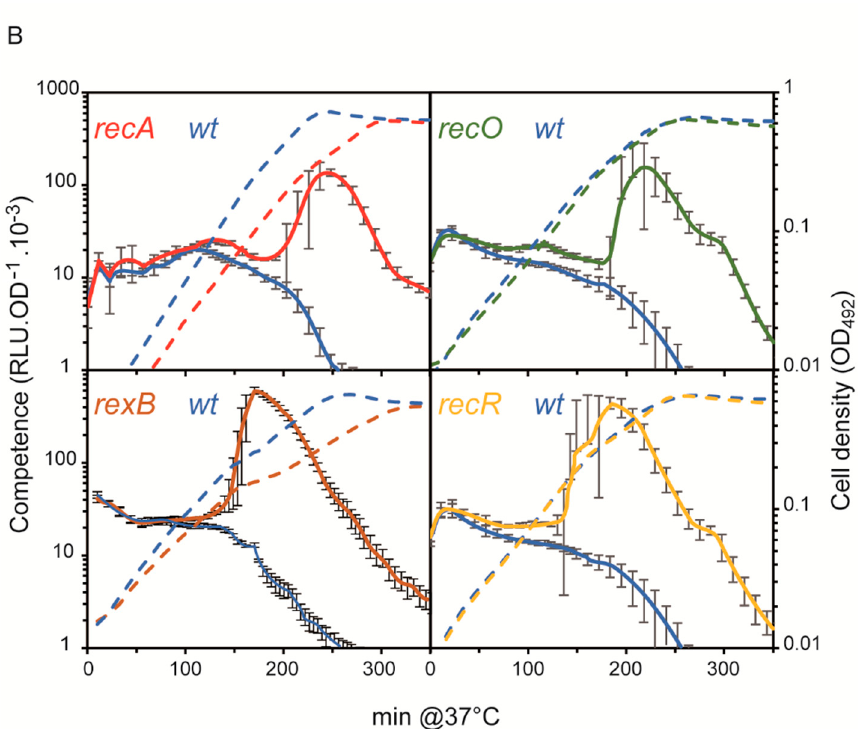
Figure 1. Pneumococcal competence development cycle: effect of repair–deficiency mutations. ( A ): Model of competence development in S. pneumoniae . The blue dots/blue line shows the devel- opment of competence in an exponentially growing culture measured by a transcriptional fusion of the luciferase gene in specific activity (Relative luminescence units (RLU) divided by the cell density (OD)); the growth curve is omitted for clarity. The core sensing and regulatory machinery of competence are composed of the comA , comB, comC (CSP), comD, and comE gene products, which define a positive feedback loop referred to as ComABCDE. The green arrow and the black T-bar rep- resent external positive and negative inputs, which balance the idling of the core sensing machinery. At some point, growth conditions will provide enough positive input to activate the ComABCDE positive feedback loop in an autocrine mode in some of the cells. Next, this fraction of cells propa- gates competence within the population in a paracrine mode by transmitting the CSP via cell-to-cell contact. In this model, the autocrine and paracrine modes of competence development proceed in two distinct periods defined as X A and X B , respectively [9]. X B is followed by shut-off of competence gene expression. The dashed grey lines represent competence gene expression during the X A and X B periods. ( B ): RecA recombination repair pathways prevent competence development. Cells were grown in C+Y medium with initial pH adjusted with HCl to inhibit competence development of the reference strains R825 or R895 (blue curves); see also Figure S1. Competence of the population is shown as solid lines (RLU.OD 492 − 1 × 10 3 ) and cell density as dashed lines (OD 492 ). Each panel shows a comparison of competence development of the WT strain with that of the mutant strains rec A − (R3309; red), rex B − (R4036; light brown), rec O − (R2411; dark green), and rec R − (R2412; orange) with that of their respective isogenic WT (wild type) strain (R825 for rec A − and rex B − strains, and R895 for the others). Data are the means of at least five independent experiments, with standard deviations shown for the RLU.OD 492 − 1